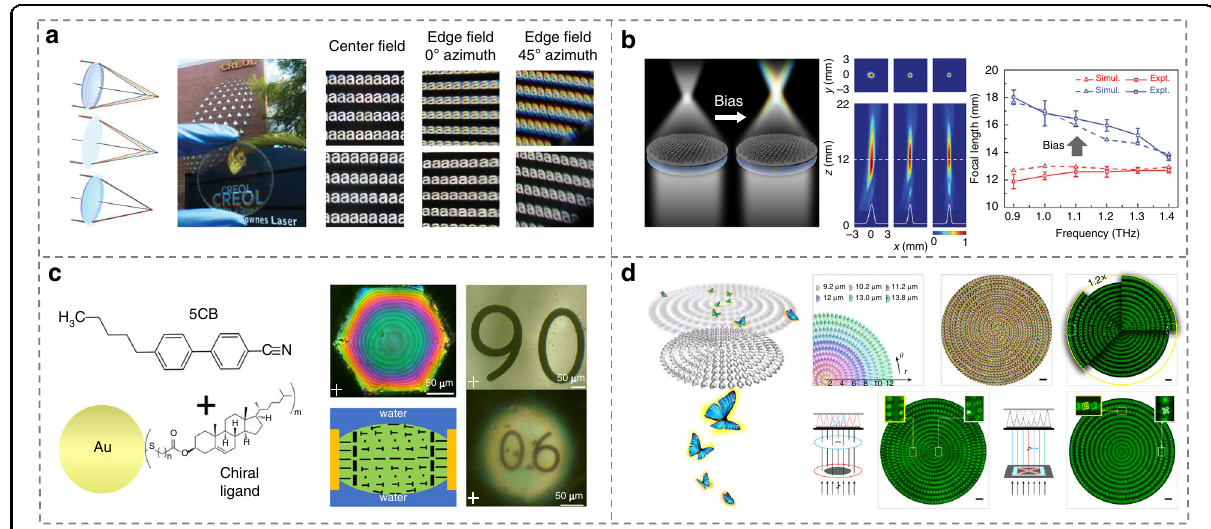
Fig. 11 LC microlenses for optical imaging. a Hybrid lens by combining the Fresnel lens and PB lens effects 216 . Reproduced from ref. 216 , with permission from Wiley-VCH. b LC based tunable chromatic aberration metalens for terahertz imaging 217 . Reproduced from ref. 217 , with permission from SPIE and CLP. c Au nanoparticle doped CLC lens immersed in water 220 . Adapted with permission from ref. 220 . Copyright 2021 American Chemical Society. d 4D visual imaging by SLC topological defects 98 . Adapted with permission from ref. 98 . Copyright 2019 American Chemical